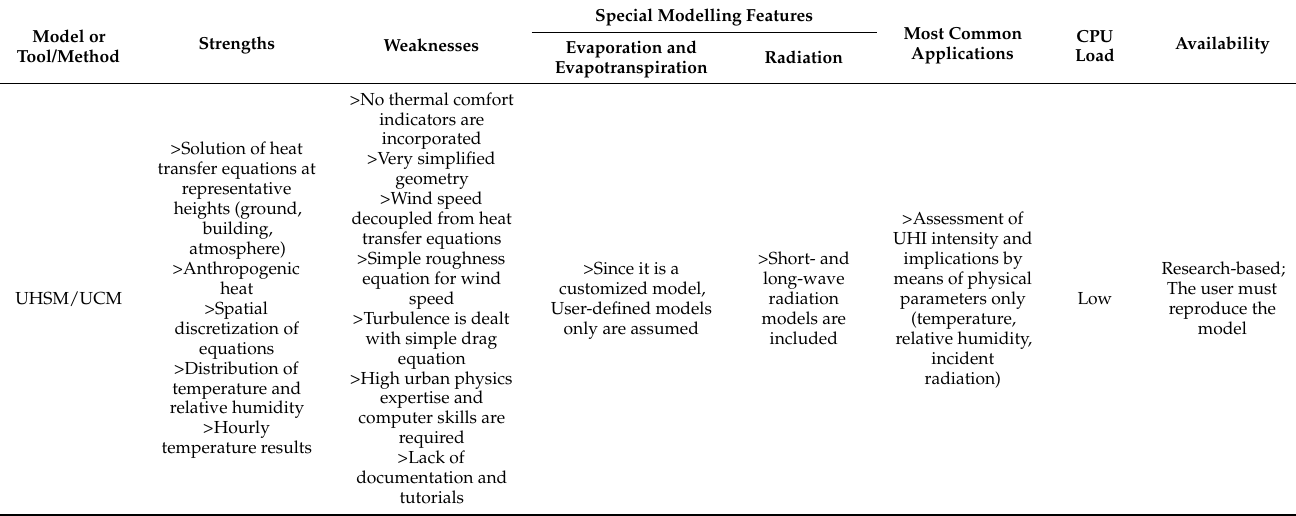
Table 4. Strengths, weaknesses, and special features of computational urban microclimate simulation models and tools. Model or Tool/Method